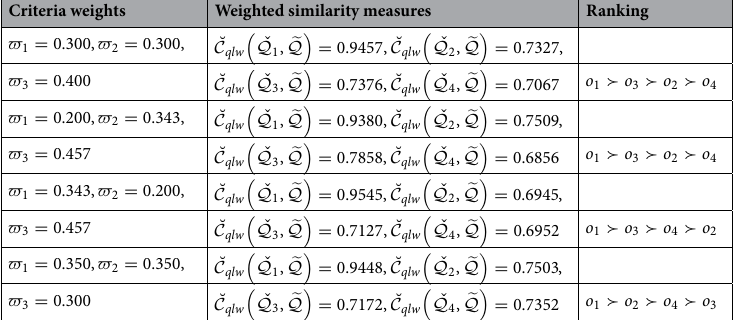
Criteria weights Weighted similarity measures